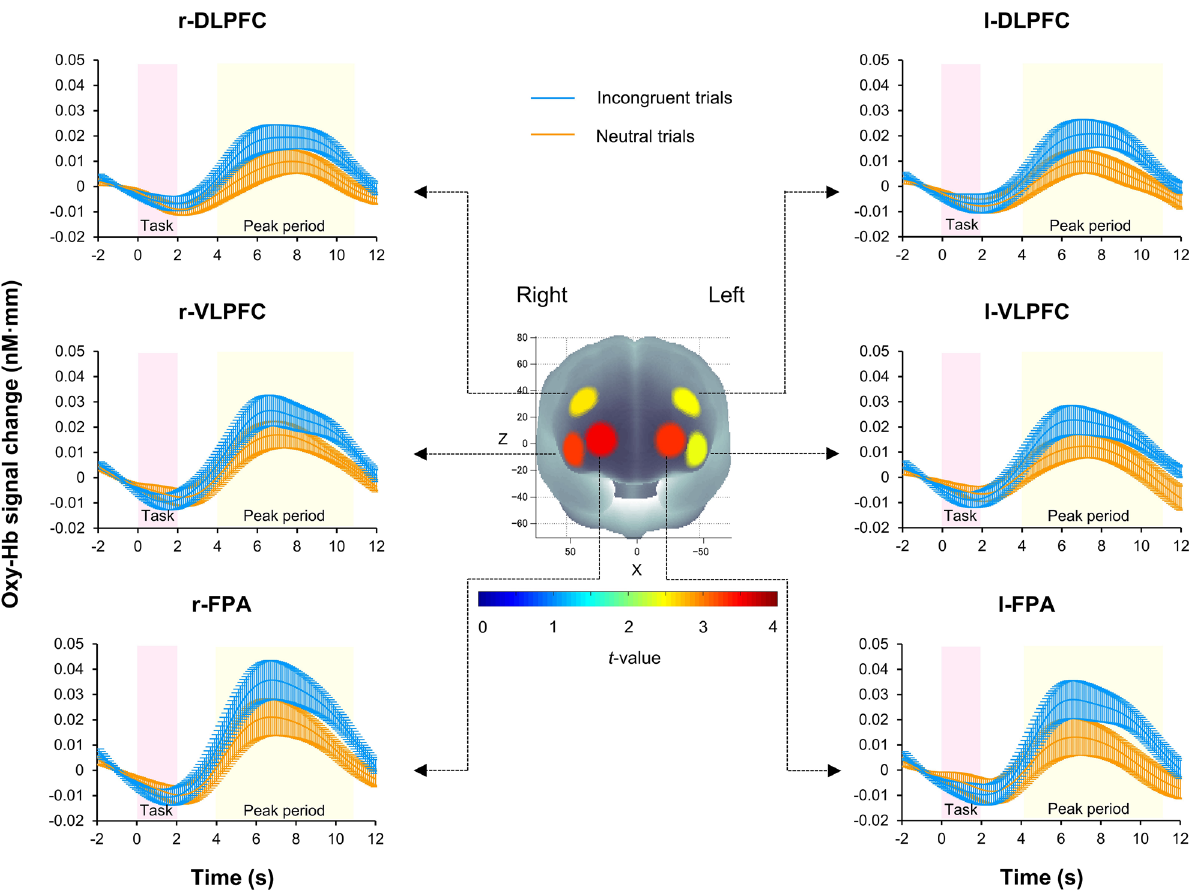
Figure 3. Cortical activation patterns during performance of the color-word matching Stroop task (CWST) in the pre-session of control and running. Presented data are average values between the pre-session of control and the pre-session of running. Baseline (2 s before trial onset) is set at zero and peak periods are indicated from 4 to 11 s after trial onset. Significant Stroop-interference-related cortical activations [incongruent—neutral] were found in all regions of interest (ROIs) indicating that the Stroop interference effect can be observed. The t -map demonstrates oxygenated hemoglobin (Oxy-Hb) signal change, t -values are indicated as in the color bar. Data are mean ±